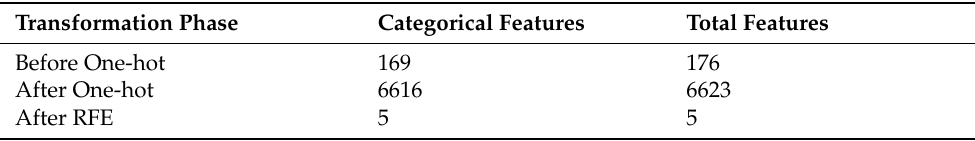
Feature Selection Using